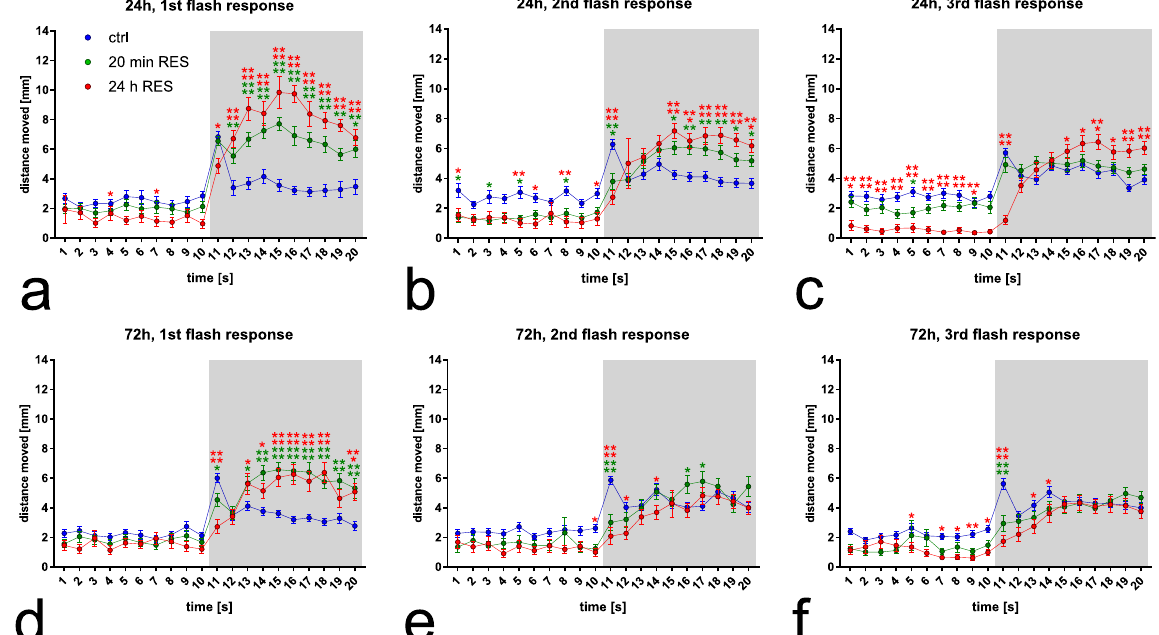
Figure 3. Locomotion during the light-dark transitions during the alternating light conditions trial from Fig. 1 at a 1 s resolution. Three consecutive transitions were analyzed at 24 h ( a – c ) and 72 h ( d – f ) after administration of reserpine. The control group shows a typical dark-induced flash response during the first second of darkness (time point 11). This activation was significantly decreased at all time points in the 24 h treated group. In the 20 min treated group, the decrease was seen at the 72 h time point, with the response being largely unaltered at the 24 h time point. The increase in locomotion during later in the dark phase could also be seen after the dark- flash time point, corresponding to results shown in Fig. 1. N = 48 in each group. Data presented as mean ± SEM. Statistical analyses were done using 2-way ANOVA followed by Tukey’s post hoc test. * p < 0.05, ** p < 0.01, *** p < 0.001, **** p < 0.0001 according to the multiple comparison